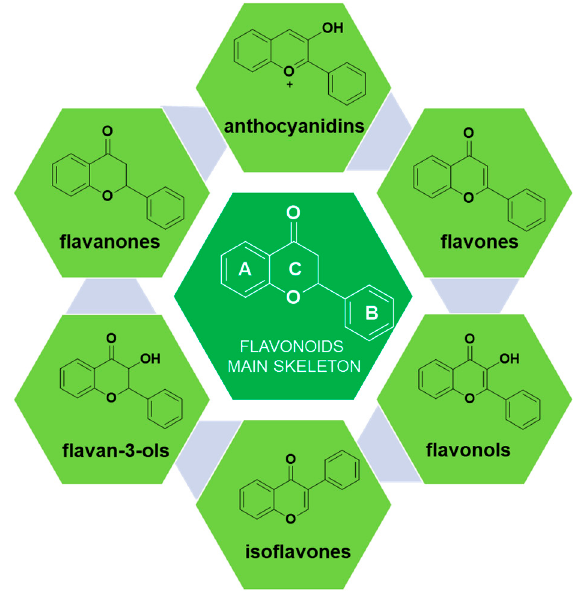
Figure 1. Flavonoid skeleton and general structures of the main flavonoid categories.